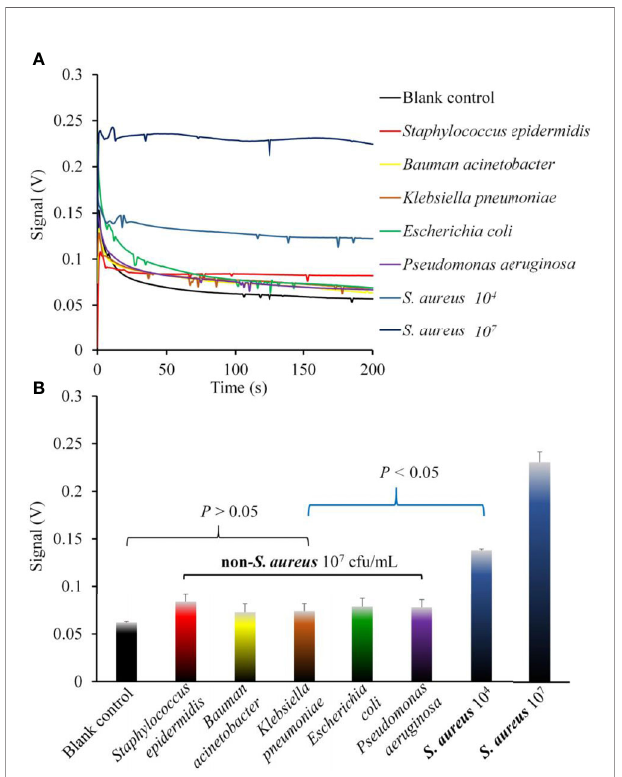
FIGURE 6 | The speci fi city of the biosensor for the detection of S. aureus compared with non- S. aureus . (A) Signal-time response trace during a complete test cycle (200 s) with the different kinds of pathogenic bacteria. (B) The optimal signal detection values of the fl uorescence intensity of S. aureus and fi ve non- S. aureus strains. The statistical analysis suggested that the signal values of all non -S. aureus groups were not signi fi cantly different from that of the blank control group ( P > 0.05), but all of them were signi fi cantly lower than that of both the two S. aureus groups (10 4 and 10 7 CFU/ml, P < 0.05). Error bars in (B) are based on standard deviations (n = 3).